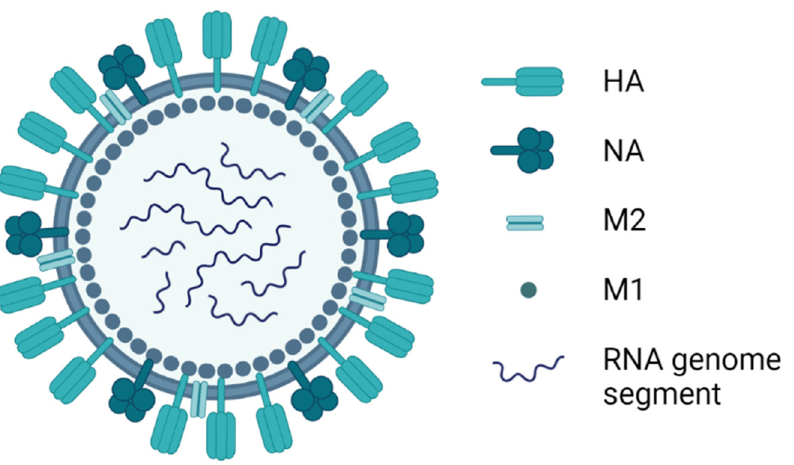
Figure 1. Graphical representation of the avian Influenza A virus particle. HA, haemagglutinin, NA, neuraminidase, M2, matrix protein 2, M1, matrix protein 1. Image created using BioRender.com.